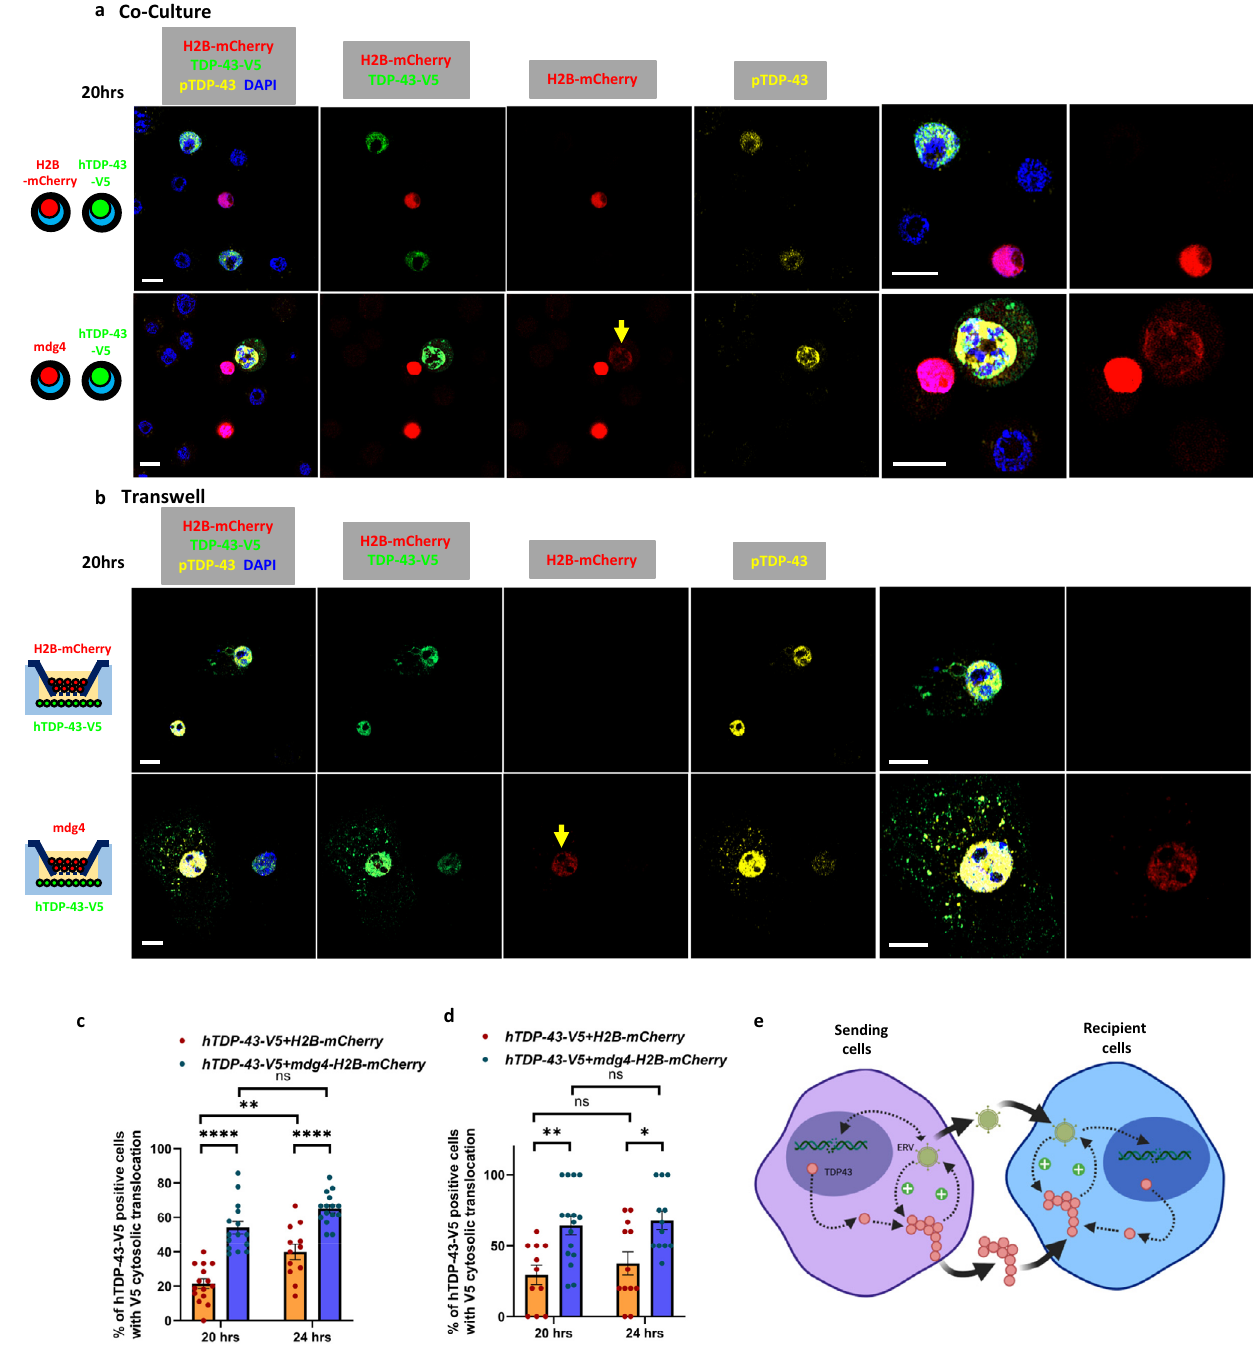
Fig. 5 | Viral transmission of mdg4-ERV from producing cells is able to cause humanTDP-43proteinopathyinrecipientcells.a Immuno fl uorescentimagesof S2 cells with staining for the V5 tag on TDP-43-V5 (green), pTDP-43 (yellow), H2B- mCherry (red) and DAPI (blue). H2B-mCherry and mdg4-H2B-mCherry as the control and producing cells were co-cultured with TDP-43-V5 recipient cells. Scale bar=5 µ m. b Immuno fl uorescentimagesofS2cellswithstainingforV5tagonTDP- 43-V5(green),pTDP-43(yellow),H2B-mCherry(red)andDAPI(blue).H2B-mCherry (control) and mdg4-H2B-mCherry (mdg4 producing cells) were cultured in oppo- sition to human TDP-43-V5 expressing recipient cells in a transwell system. Scale bar=5 µ m. c Quanti fi cationofthe%ofS2cellswithcytoplasmicV5translocationto cytoplasm in co-culture of hTDP-43-V5 with H2B-mCherry and hTDP-43-V5 with mdg4-H2B-mCherryafter20h(21.46±2.80%, n =15examined fi elds;54.00±3.65%, n =15 examined fi elds) and 24h (39.98±4.45%, n =12 examined fi elds; 65.07±2.39%, n =15 examined fi elds) after induction of hTDP-43-V5. Data